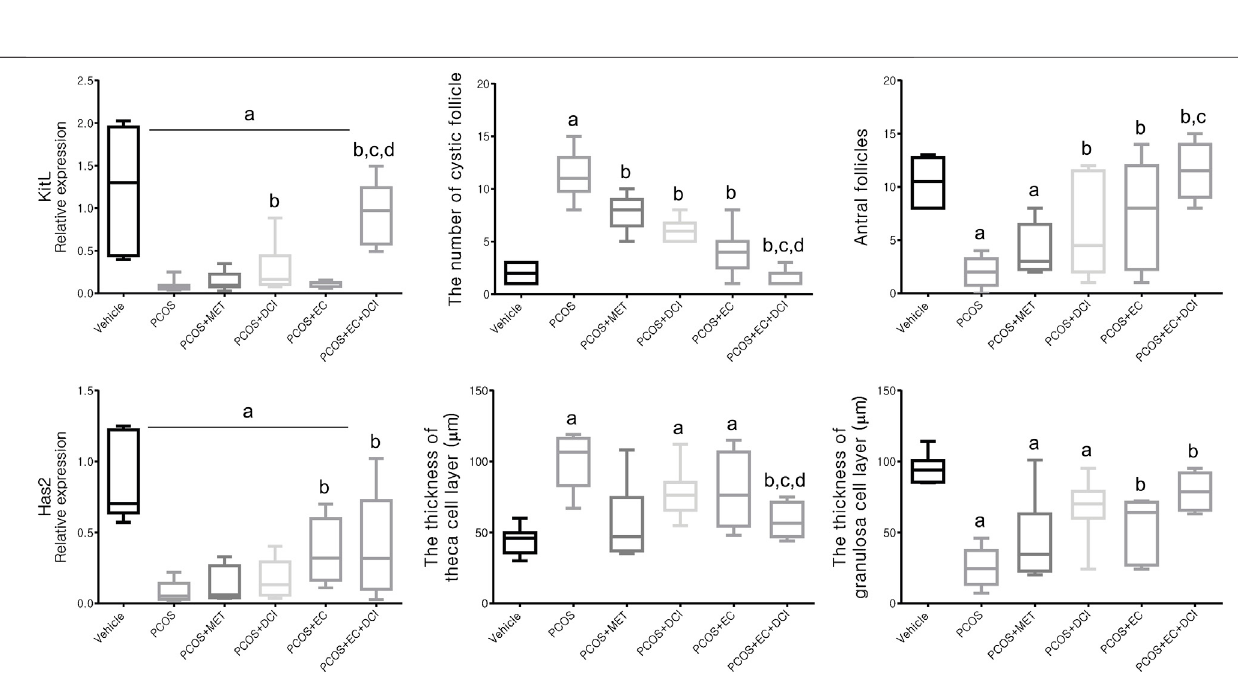
FIGURE 5 | Effect of EC extract and DCI on follicular genesis and histologic features of ovarian follicles in PCOS rats. Relative gene expression related to follicular genesis involving KIT ligand ( Kitl ) and hyaluronan synthase 2 ( Has2 ) as assessed by quantitative Real-Time PCR. Rplp0 was used as an internal control. All values representmean±SD. a p < 0.05vs.vehicle, b p < 0.05vs.PCOS, c p < 0.05vs. PCOS+DCI; d p < 0.05vs. PCOS+EC.MET,metformin;EC, Eckloniacava K.;DCI, d-chiro